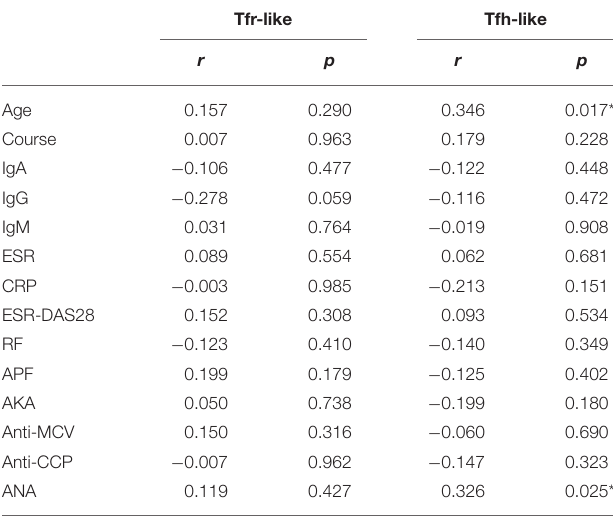
Correlations were assessed using Spearman’s rank test. * p < 0.05. AKA, anti-keratin antibody; ANA, anti-nuclear antibody; anti-CCP, anti-cyclic citrullinated peptide; anti-MCV, anti-mutated citrullinated vimentin; APF, anti-perinuclear factor; CRP, C-reactive protein; DAS28, Disease Activity Score-28; RF, rheumatoid factor; ESR,